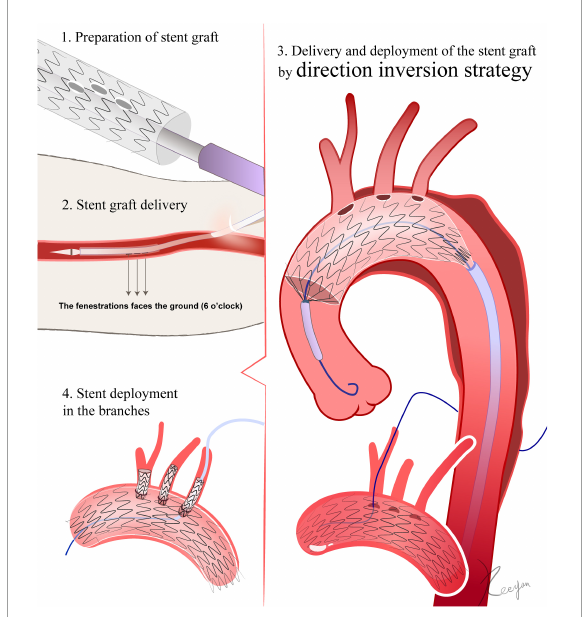
FIGURE3 Direction inversion strategy. 1. The fenestration is made in vitro according to the peri-operative CTA. 2. The front of the trigger is regarded as the 12 o’clock position. When the stent graft is inserted through the femoral artery access, the 12 o’clock marker point must be turned vertically to the ground, so that it faces 6 o’clock. The stent graft is not allowed to rotate after entering the femoral artery until it reaches the aortic lesion. 3. After passing the aortic arch, the fenestration mark is aligned with the branch artery’s corresponding position. After the deployment of the stent graft, a 0.018-inch guidewire is advanced through the fenestration. 4. Deployment of stents in the